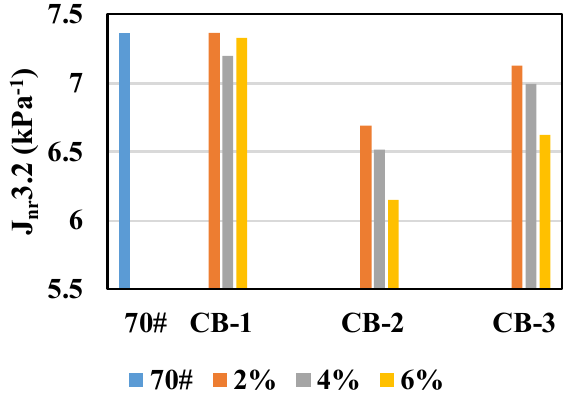
Figure 5. J nr 3.2 values of unaged asphalt specimens.